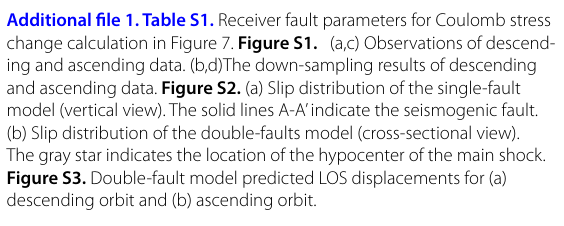
Additional file 1. Table S1. Receiver fault parameters for Coulomb stress change calculation in Figure 7. Figure S1. (a,c) Observations of descend- ing and ascending data. (b,d)The down-sampling results of descending and ascending data. Figure S2. (a) Slip distribution of the single-fault model (vertical view). The solid lines A-A’ indicate the seismogenic fault. (b) Slip distribution of the double-faults model (cross-sectional view). The gray star indicates the location of the hypocenter of the main shock. Figure S3. Double-fault model predicted LOS displacements for (a) descending orbit and (b) ascending